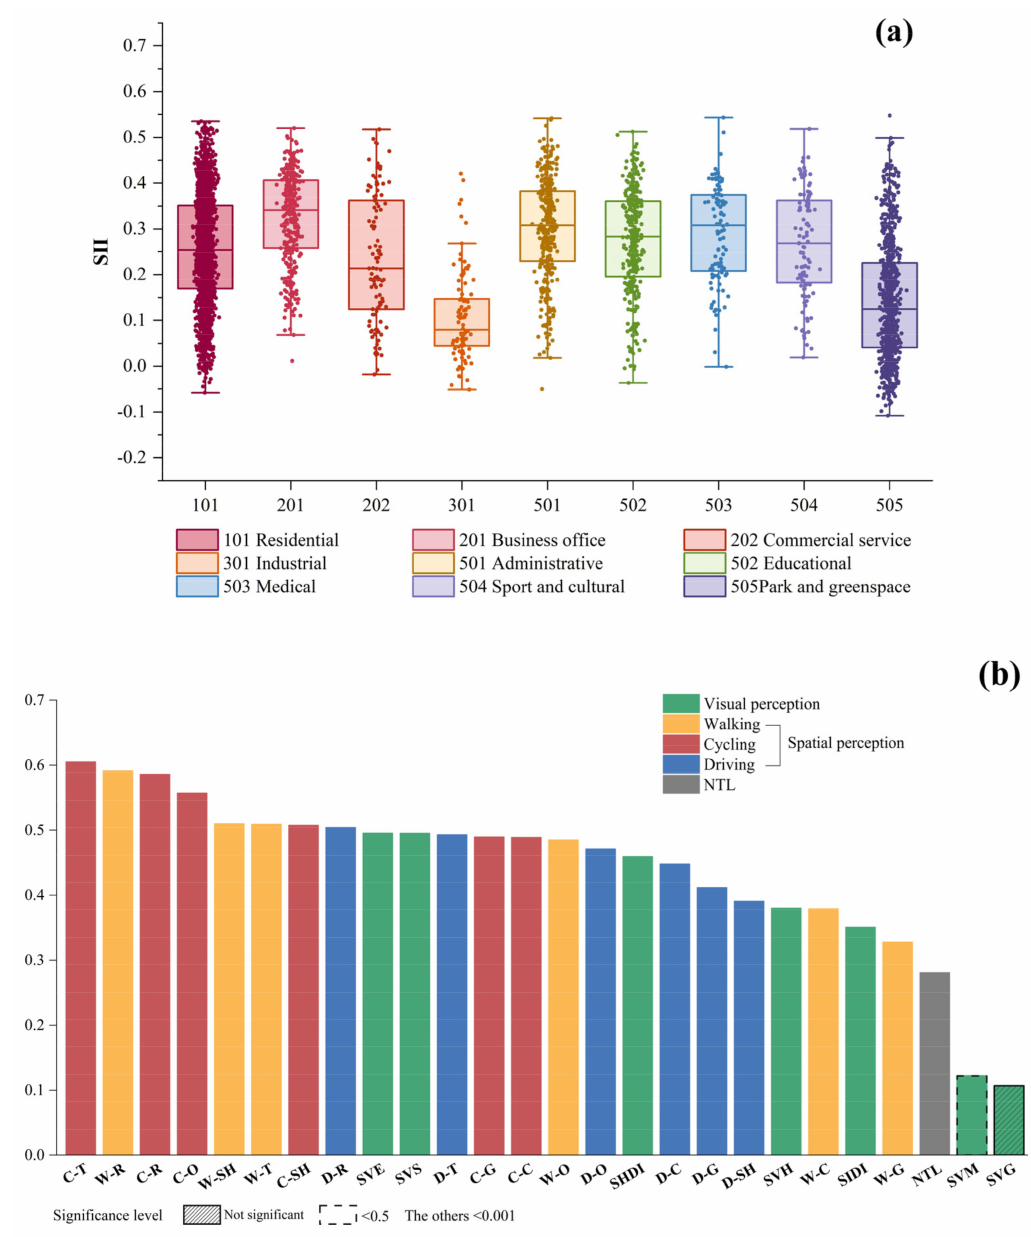
Figure 12. ( a ) Settlement intention index (SII) values of different land use categories, ( b ) influence of perception factors on the density of total population distribution (DTP), sorted from high to